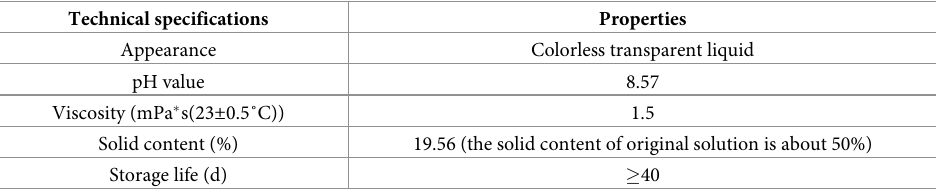
Table 1. The technical specifications of impregnated